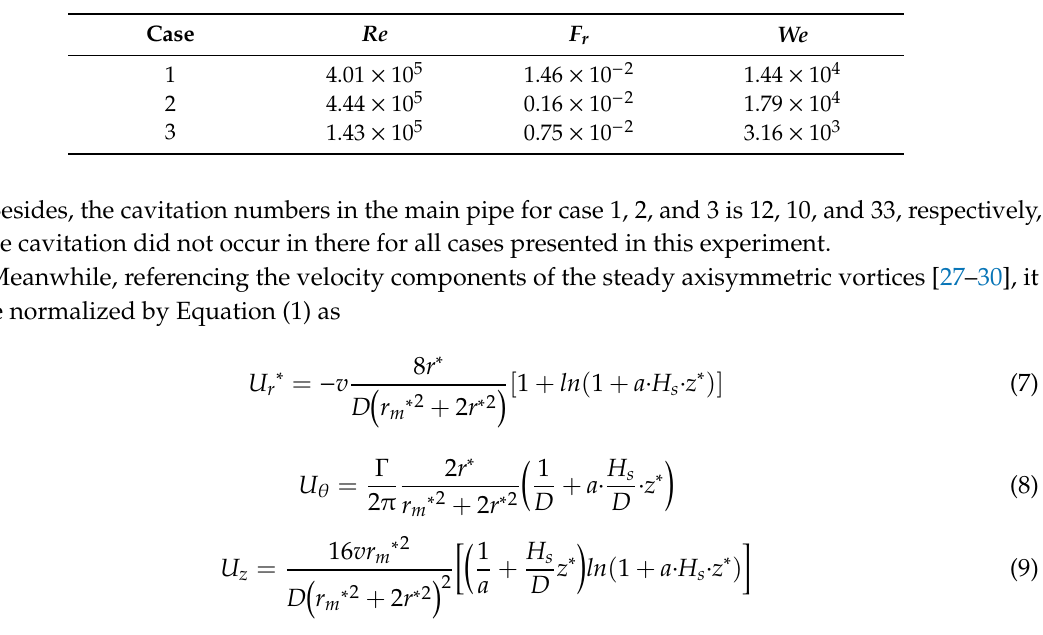
Table 1. Pump intake dimensionless